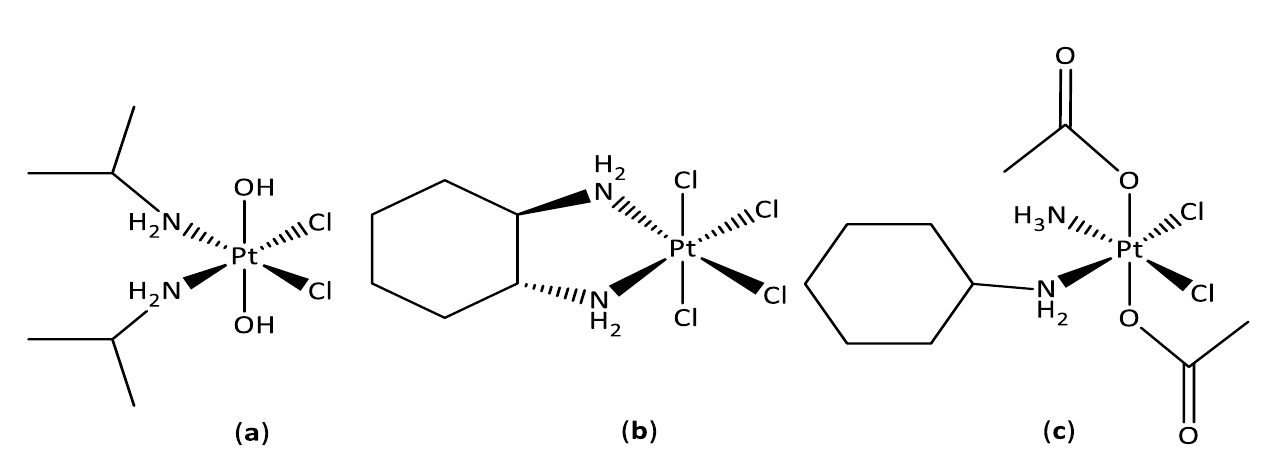
Figure 2. The chemical structures of platinum(IV) compounds iproplatin ( a ), tetraplatin ( b ), and satraplatin ( c ) that entered clinical trials.